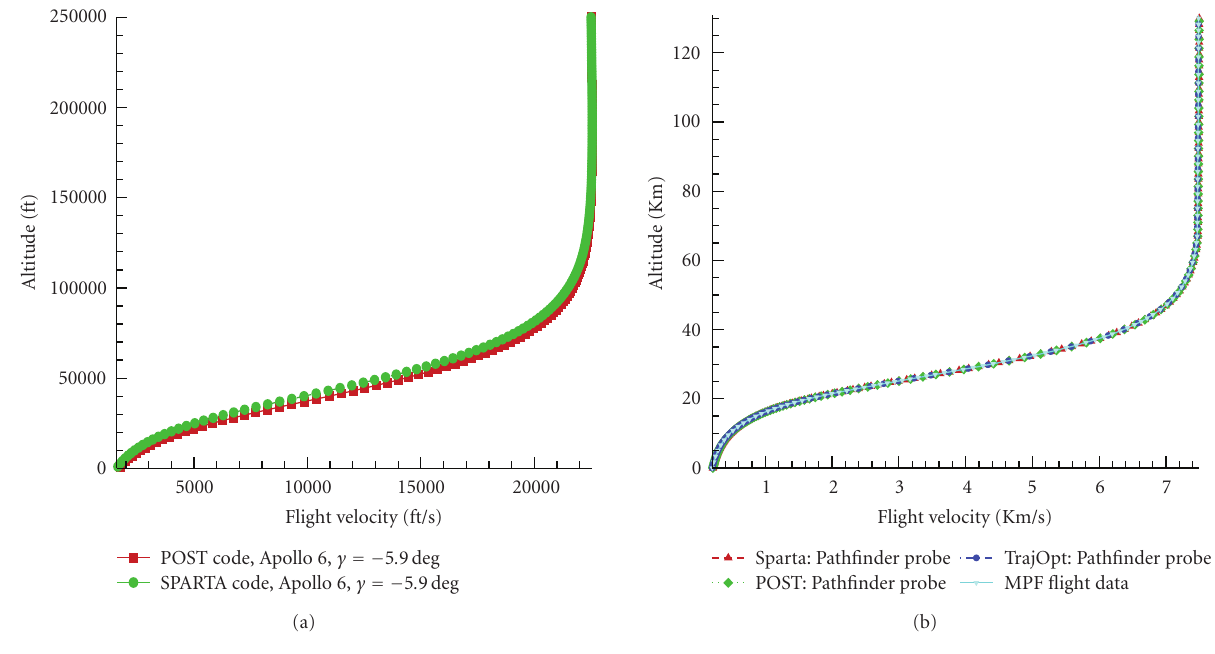
Figure 16: (a) SPARTA versus POST. (b) SPARTA versus POST and TrajOpt.